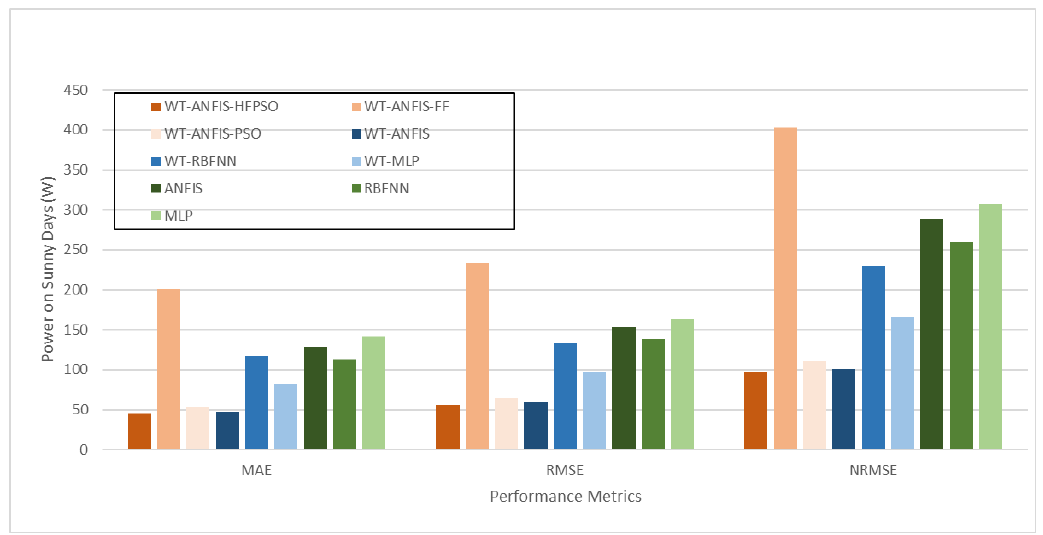
Figure 10. Comparison of forecasting models in terms of the MAE, RMSE and RMSE on sunny days.